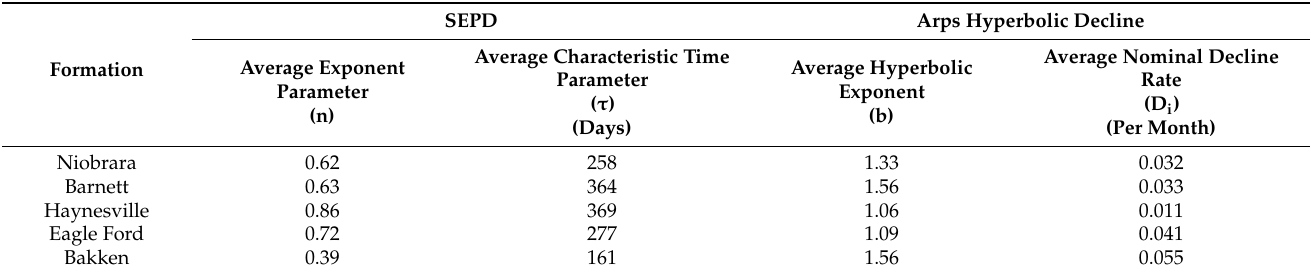
Table 8. Average decline parameters for all wells in each formation for the SEPD and Arps hyperbolic decline models. SEPD Arps Hyperbolic Decline Average Characteristic Time Average Exponent Formation Parameter Parameter (n) Niobrara